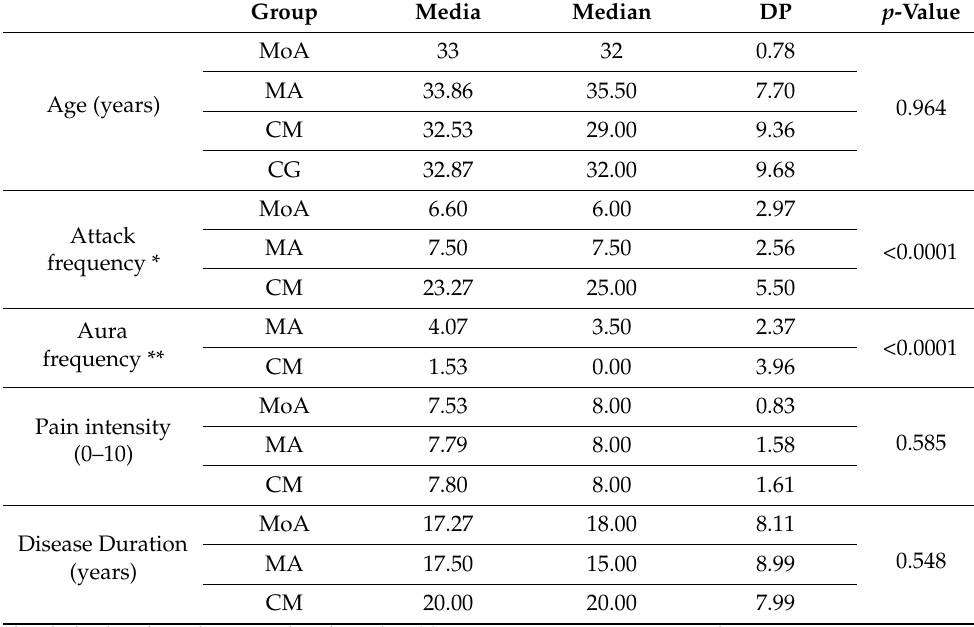
Table 1. Sample clinical